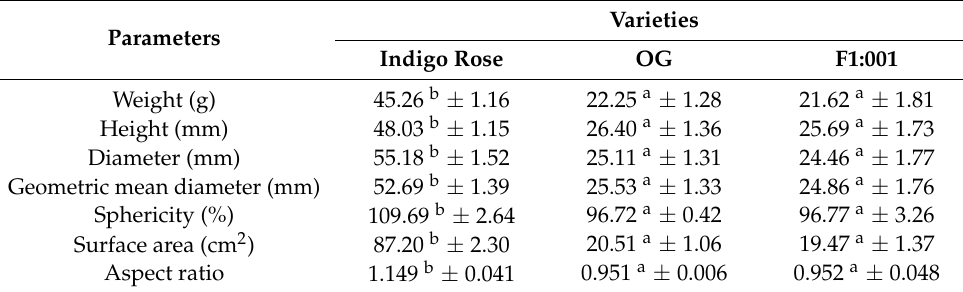
Figure 1. Three varieties of black cherry tomatoes grown in Vietnam. (a) Indigo Rose variety; (b) OG variety; (c) F1:001 variety. Table 1. Fruit weight and size of three varieties of black cherry tomatoes.